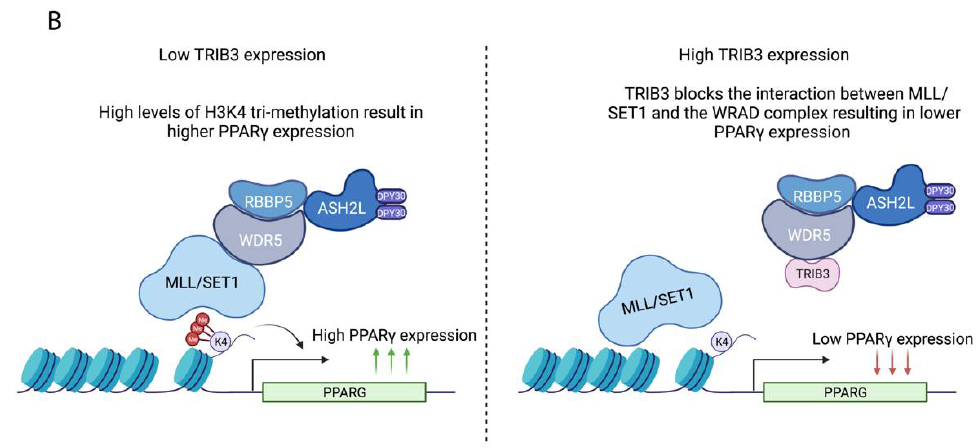
Figure 6. TRIB3 levels affects the sensitivity of MCF7 cells to TZD treatment. ( A ) Sh-control, shTRIB3 and TRIB3-tGFP-inducible MCF7 cells were treated for 72 h with rosiglitazone at 40 µ m. TRIB3-tGFP-inducible cells were treated with or without doxycycline for 24 h before cell viability was measured. Data are indicated as mean ± SEM. p -values were calculated using two-tailed Student’s t -test *** p < 0.001) ( B ) Schematic representation of the role of TRIB3 as an epigenetic regulator.